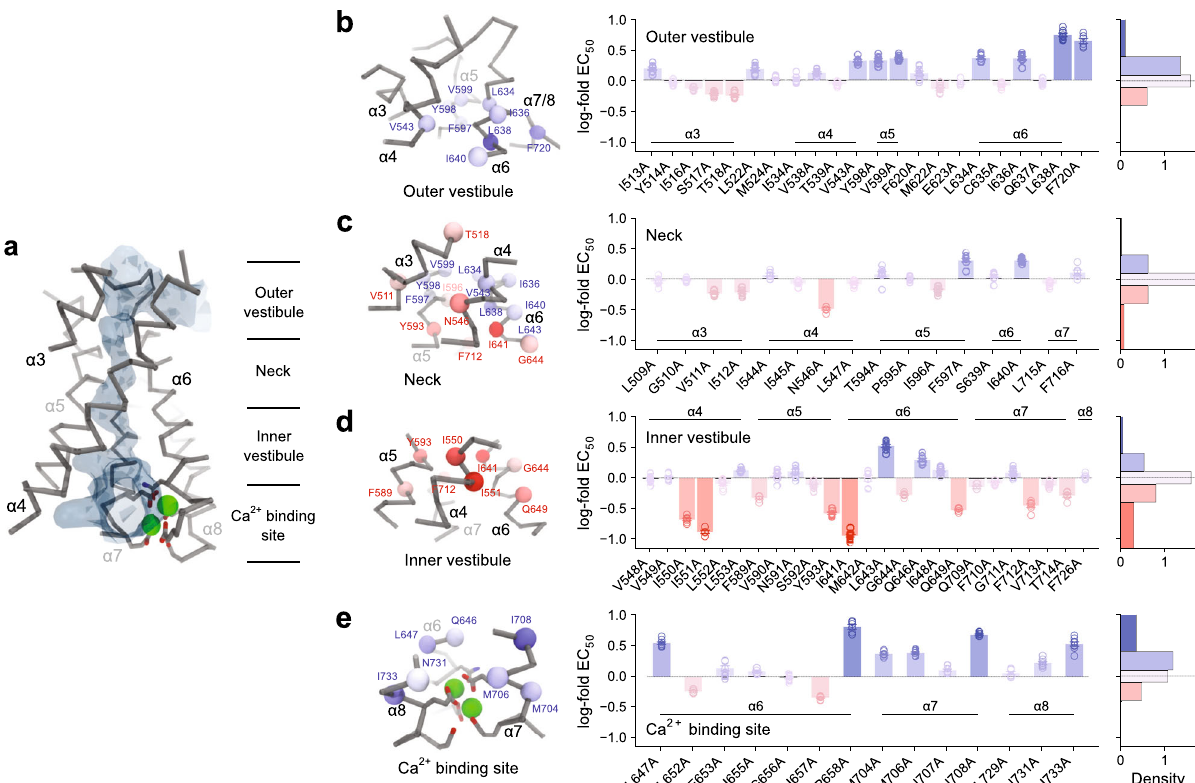
Fig. 1 Characterization of pore residues by systematic mutagenesis. a C α representation of the pore contained in a single subunit of TMEM16A (PDB: 5OYB) with different regions indicated. Blue surface encloses the water-accessible volume of the pore calculated in HOLE 53 with a probe radius of 1.15 Å. b – e Summary of Ca 2 + concentration-response relationships of Ala mutants in different regions of the pore. b Outer vestibule, c neck, d inner vestibule, and e Ca 2 + binding site. Red indicates a left-shift, and blue a right-shift in the EC 50 . Left, sections of the pore with C α atoms of selected mutated residues shown as spheres and colored according to the effect on Ca 2 + potency. Center, Ca 2 + potencies of mutants. The logarithm of the fold-change in EC 50 of each investigated residue compared to wild type (WT) is shown. Individual measurements are displayed as circles, bars show averages of the indicated number of patches shown in Supplementary Tables 1 – 3, and errors are SEM. Right, histogram of EC 50 shifts in the corresponding region. a , e Ca 2 + -binding residues are shown as sticks and bound Ca 2 + ions as green